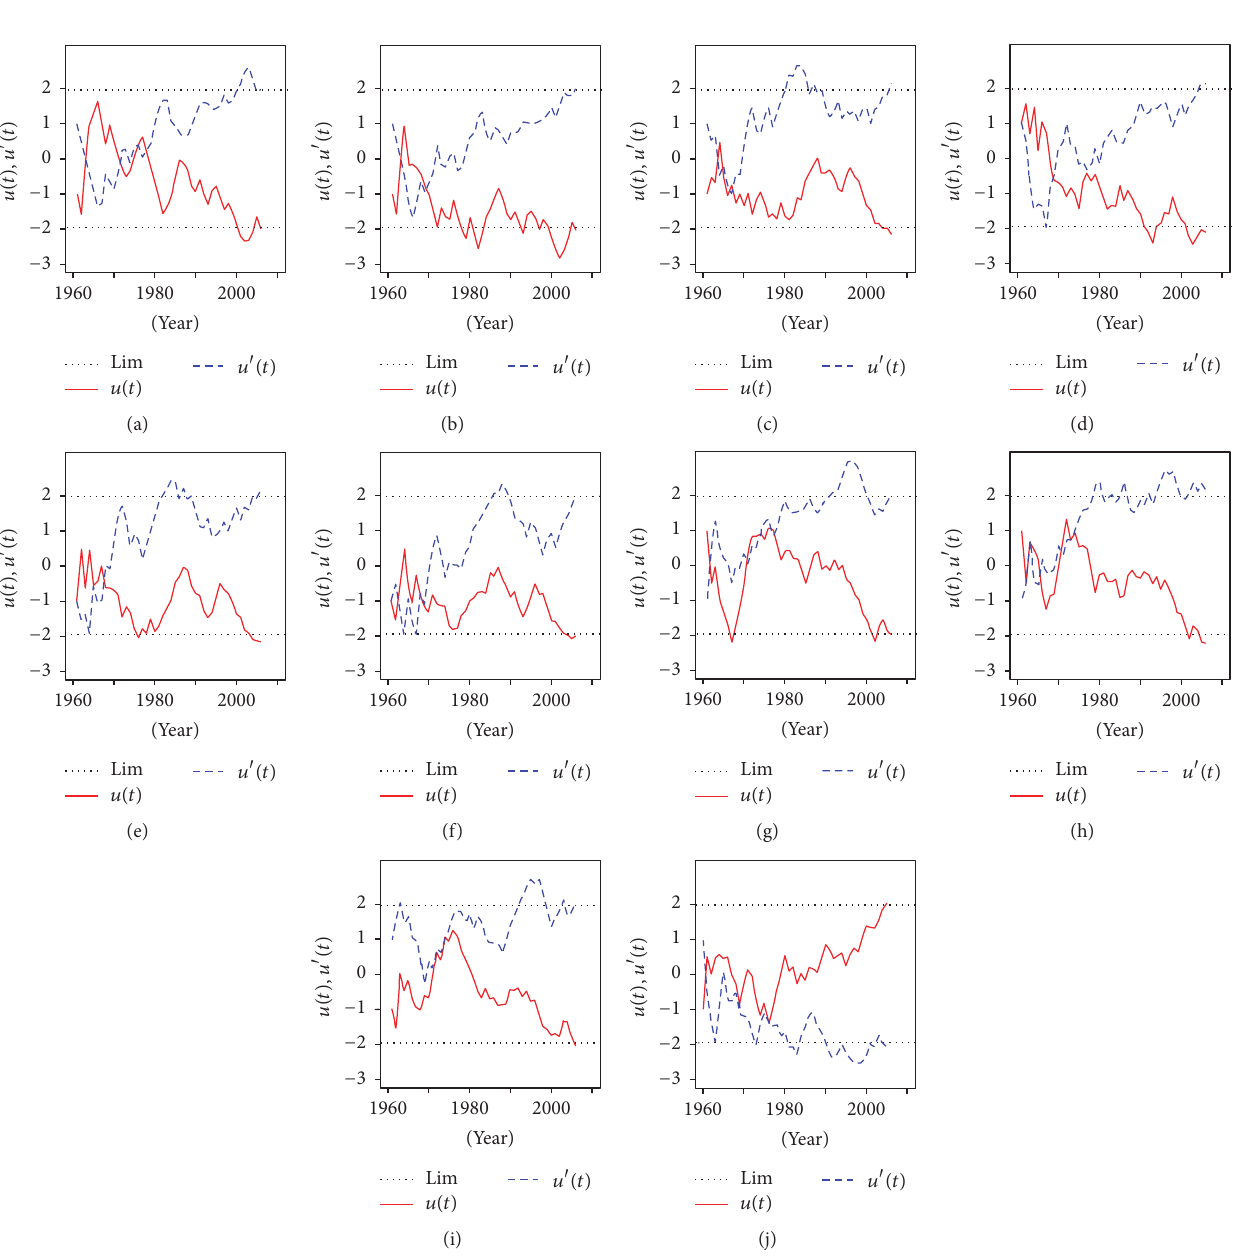
Figure 6: Graphical representation of the forward series 𝑢(𝑡) and backward series 𝑢 󸀠 (𝑡) of Sequential Mann-Kendall Rank Statistic test: (a) Changtu annual precipitation, (b) Xifeng annual precipitation, (c) Xiuyan annual precipitation, (d) Dalian summer precipitation, (e) Xiuyan summer precipitation, (f) Zhuanghe summer precipitation, (g) Benxixian autumn precipitation, (h) Qingyuan autumn precipitation, (i) Yingkou autumn precipitation, and (j) Yixian winter precipitation. Two limit lines are the upper and lower critical values ( ± 1.96, 𝑝 = 0.05 ), respectively. Sequential Mann-Kendall Rank Statistic test is applied only if changing trend of annual and seasonal precipitation series is statistically significant at 𝑝 = 0.05 by using Mann-Kendall